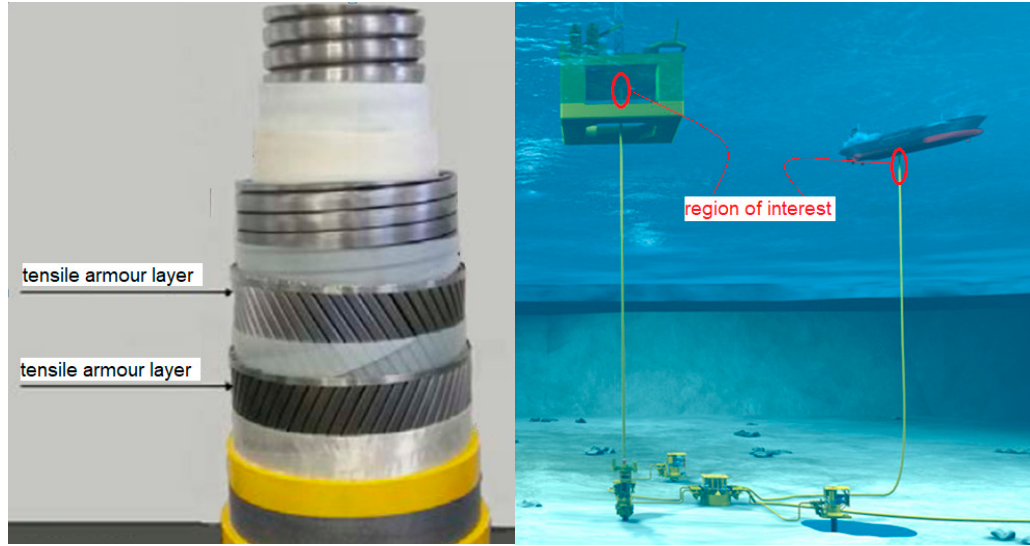
Figure 1. ( a ) The different layers of a typical riser, ( b ) the region of the riser that could be monitored using techniques based on guided wave propagation.